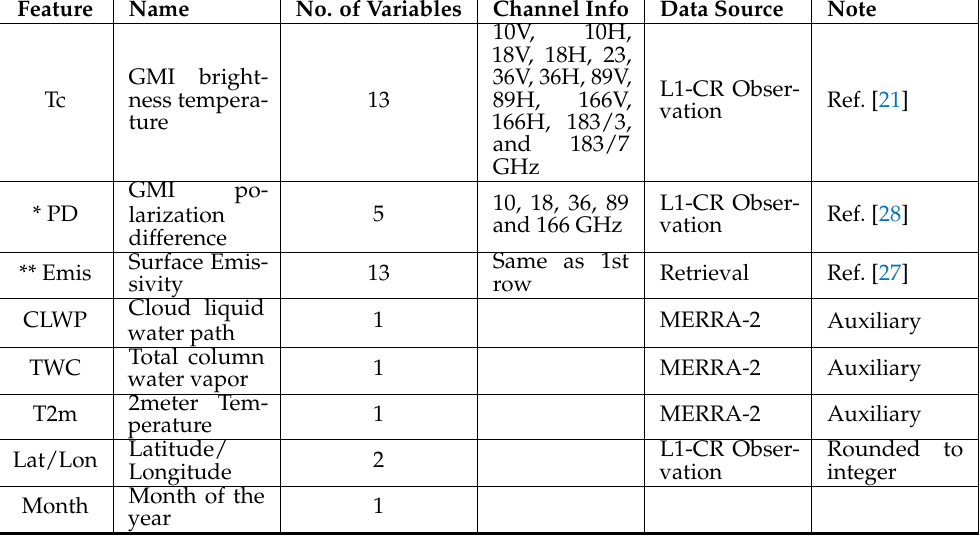
Table 1. Features used as input (* = hand-engineered feature; ** = retrieval using GMI TB [27]).